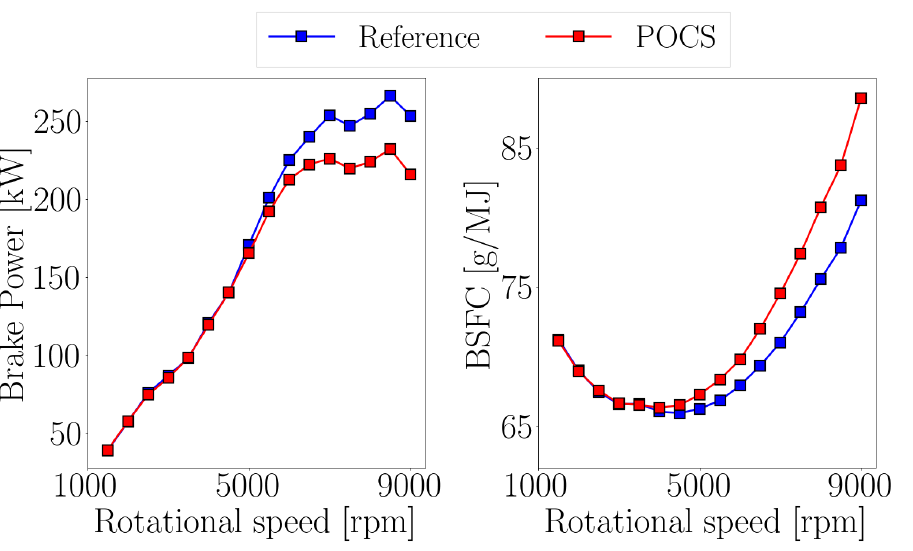
Figure 10. Assessment of the POCS pressure drop: 1D performance simulation—brake power and brake specific fuel consumption: reference vs.